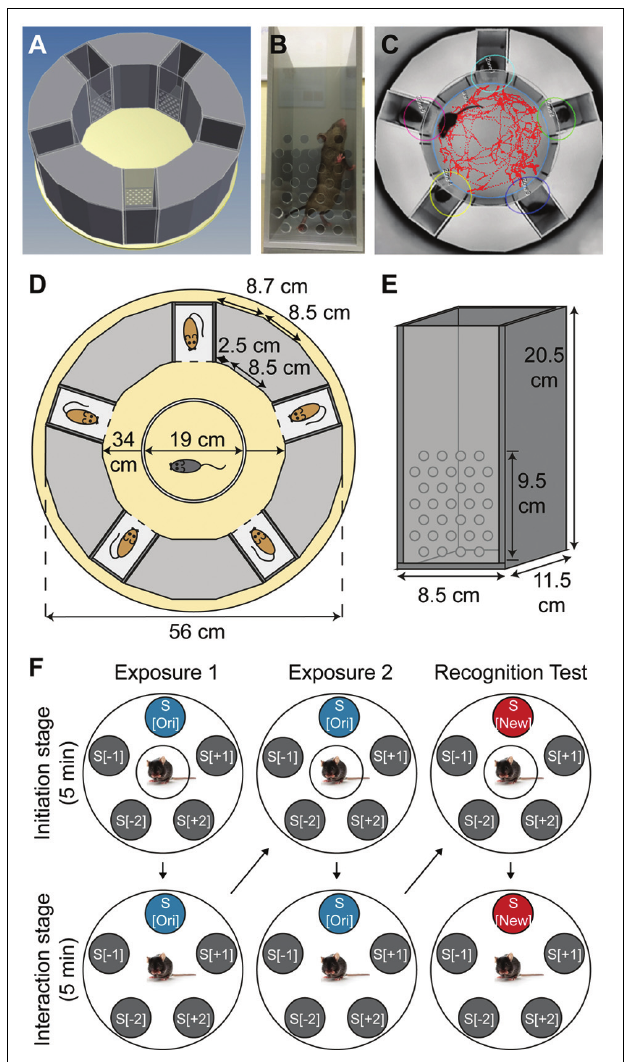
FIGURE 1 | Design of the SocioBox paradigm. (A) 3-dimensional representation of the SocioBox apparatus, showing the ring of stimulus mouse inserts around the central arena containing the experimental mouse. (B) Photograph of a stimulus mouse insert. (C) Image from the Viewer3 software, showing the digital mouse track and interaction zones overlaid on a photograph from the overhead camera. (D) Construction diagram of the SocioBox chamber. The floor plate is shown in light yellow; the 5 inserts are shown in dark gray (each containing a stimulus mouse); the plastic walls are shown in light gray; the circular partition is shown in white. (E) Construction diagram of an insert. The insert walls are shown in dark gray; the detachable clear front slider is shown in light gray. The dimensions of each element are indicated with arrows. (F) Flow chart of the test session on day 4. The large circles represent the SocioBox apparatus; the small filled circles represent the stimulus mouse inserts; the circles around the experimental mouse in the center represent the central circular partition. The columns represent the 3 phases of the test session, exposure 1, exposure 2, and recognition test. The rows represent the 2 stages, the initiation stage (experimental mouse separated from the stimulus mice by the circular partition) and the interaction stage (circular partition removed). Arrows indicate the progression of the experiment. S[ori] = original stimulus mouse; S[new] = new stimulus mouse; S[ − 1] and S[ + 1] = stimulus mice immediately adjacent to the S[ori]/S[new] mouse; S[ − 2] and S[ + 2] = stimulus mice opposite the S[ori]/S[new]